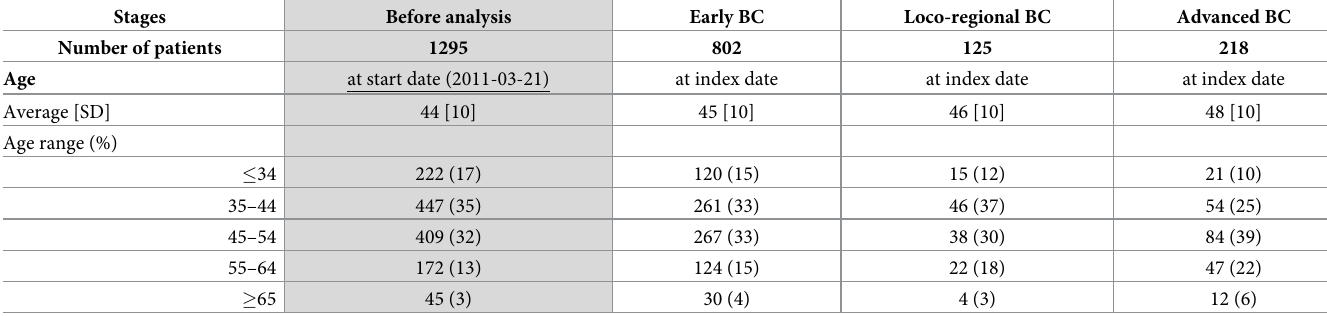
Table 1. Age characteristics of study patients with HER2-positive